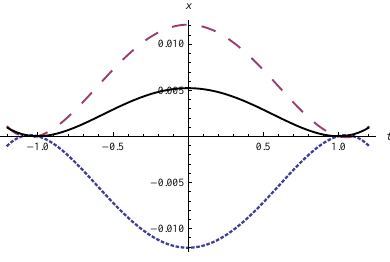
Figure 1. The solution of problem (4.5) and corresponding upper and lower functions. The solid line in Fig. 1 indicates a solution of problem (4.5) and dashed lines present the corresponding upper and lower